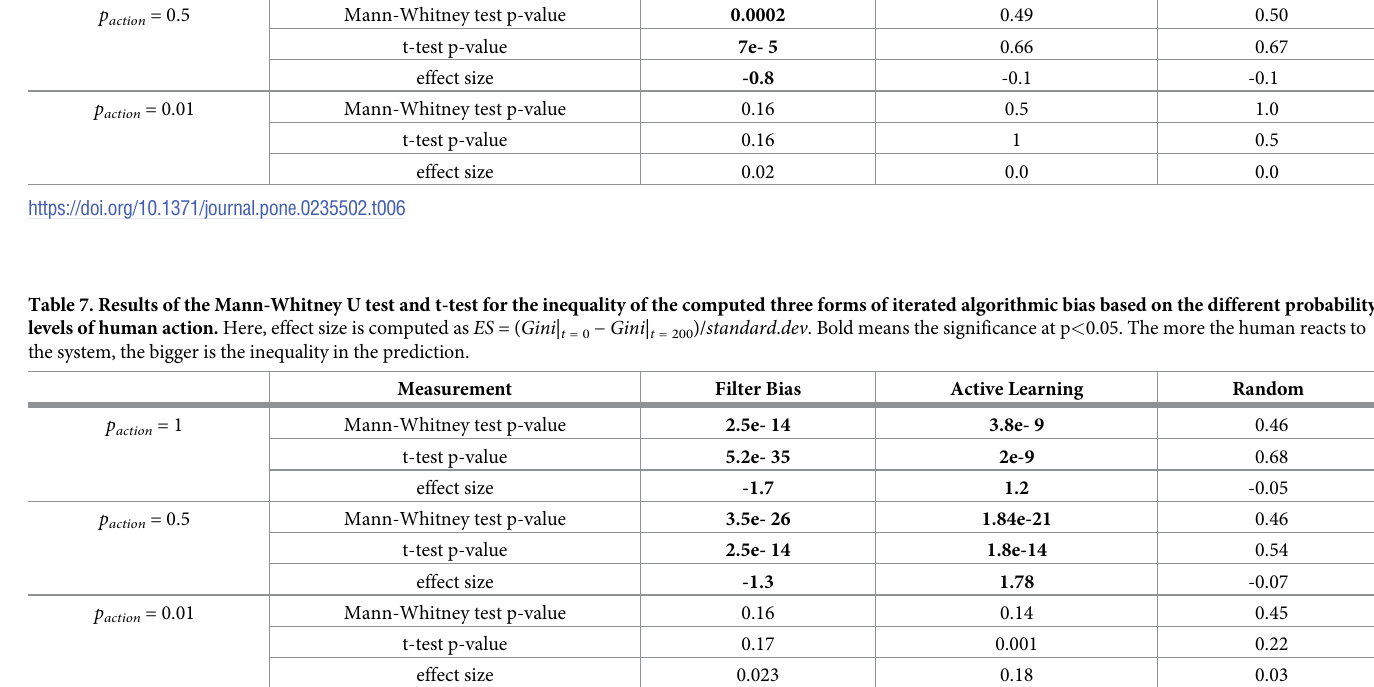
compare the inequality induced by each algorithmic bias form, alone. We do so by analyzing the Gini coefficient. We perform the Mann-Whitney U statistical test to see whether the human action will lead to different trends in the inequality of prediction. We run experiments with different human action probabilities, namely 1.0, 0.5 and 0.01, and compare the inequal- ity between the first iteration and last iteration. Table 7 shows that higher human action